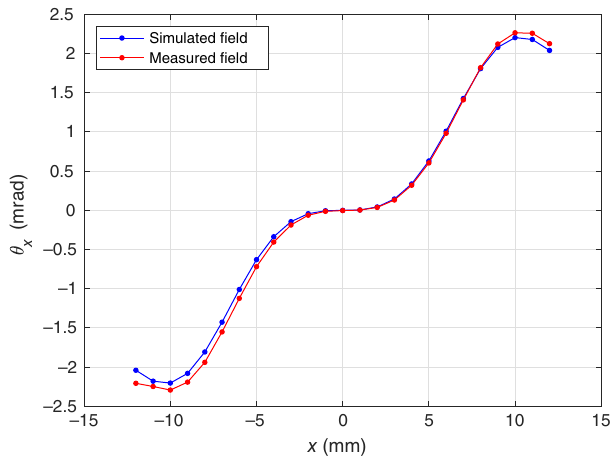
FIG. 8. Horizontal variations of the measured (red) and the ideal simulated (blue) horizontal kick θ x , at z ¼ 0 and t ¼ 1 . 2 μ s, scaled to match the operation at 10 kV. The measured field satisfactorily matches the simulated field in the field-free region and on the injected beam path at x ¼ 10 . 3 mm.